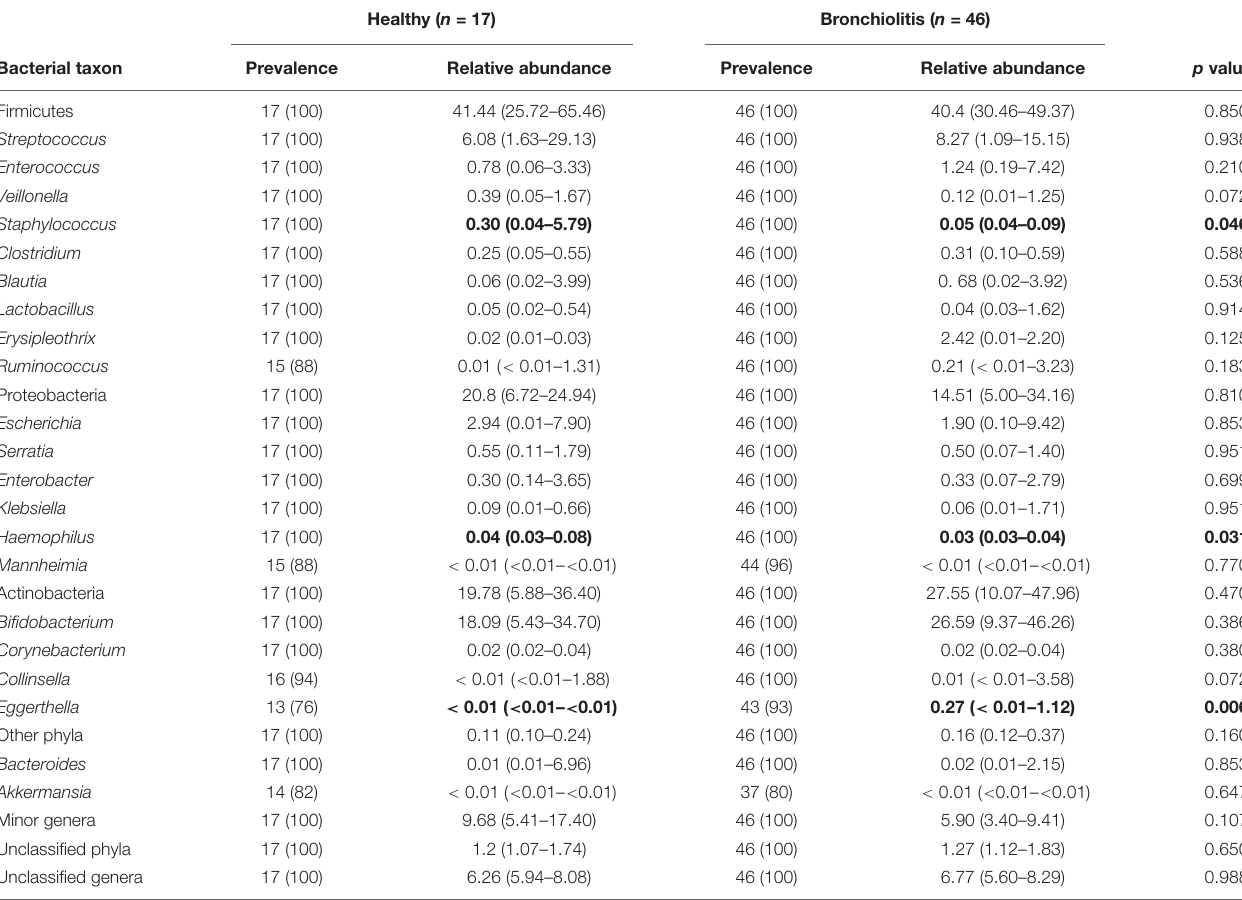
TABLE 2 | Relative abundance of main bacterial phyla and genera in fecal samples from healthy control and bronchiolitis